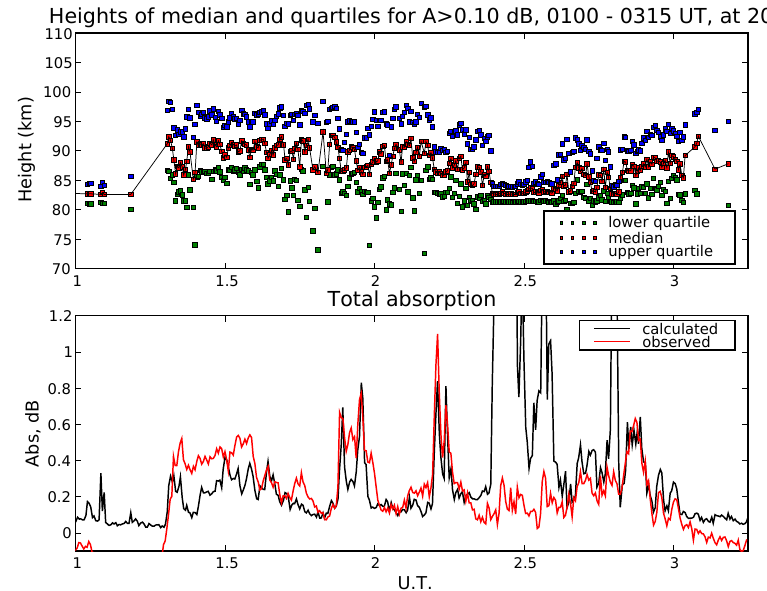
Fig. 10. The absorption layer for 01:00–03:15 UT (01.00–03.25 UT) on 2 July. The upper panel shows the calculated median and quartiles, and the lower one compares the calculated 38.2MHz absorption with that observed with the Kilpisj¨arvi imaging